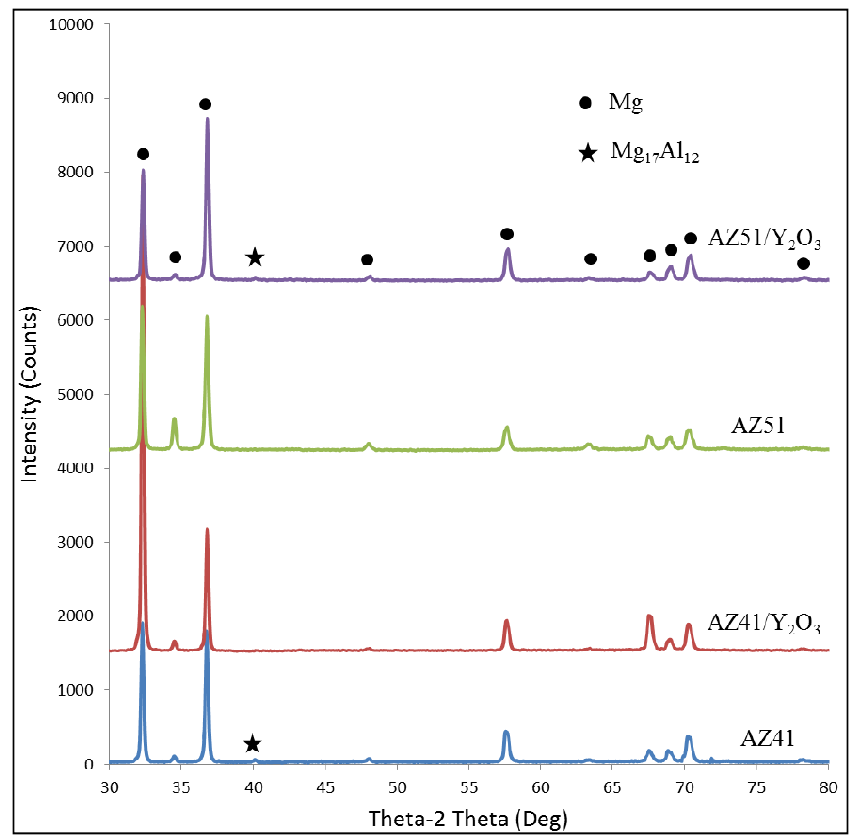
Figure 3. X-ray diffractograms of the synthesized materials.